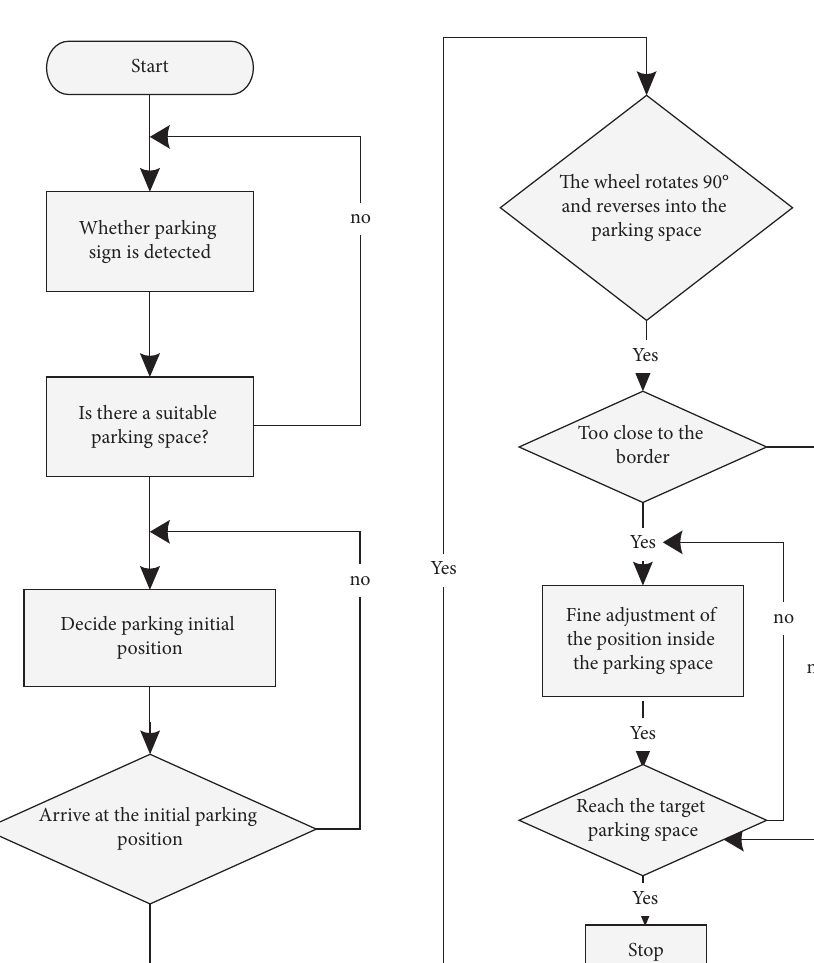
Figure 2: CI/CD of